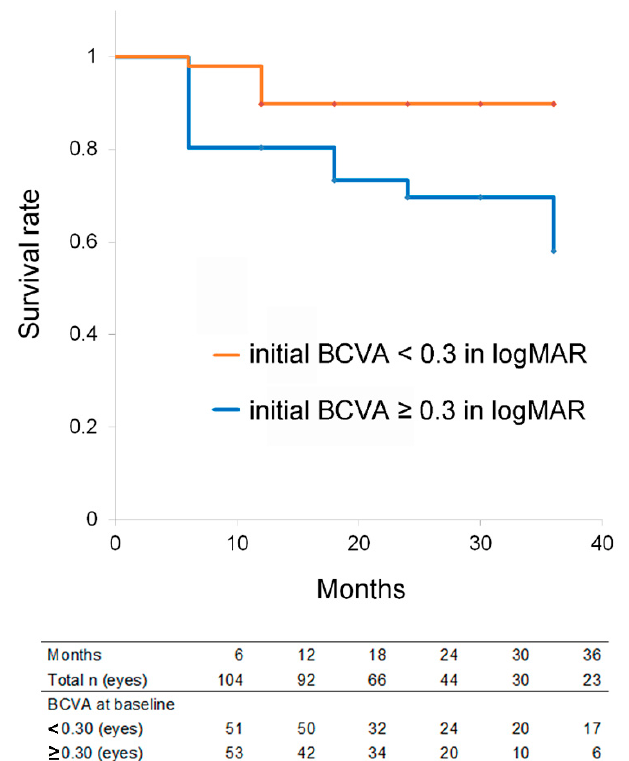
Figure 2. The Kaplan–Meier survival analysis after anti-vascular endothelial growth factor treatment in age-related macular degeneration. Failure was defined as a best-corrected visual acuity (BCVA) reduction ≥ 0.2 of the logarithm of the minimum angle of resolution (logMAR) from the initial BCVA. The eyes with an initial BCVA better than 0.3 in logMAR (shown in orange) had a better survival rate than those with an initial BCVA equal or worse than 0.3 (shown in blue). p = 0.014 by logrank test. The number of eyes at each time point is shown.